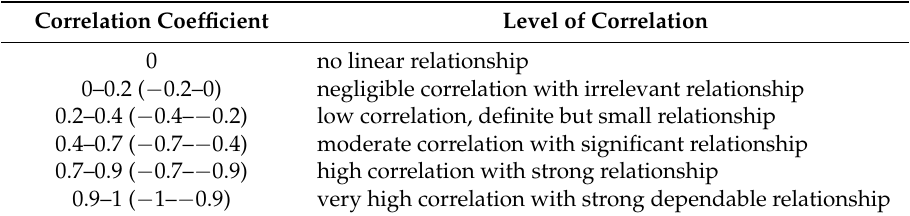
Table 1. Correlation coefficient (Guilford, 1950).